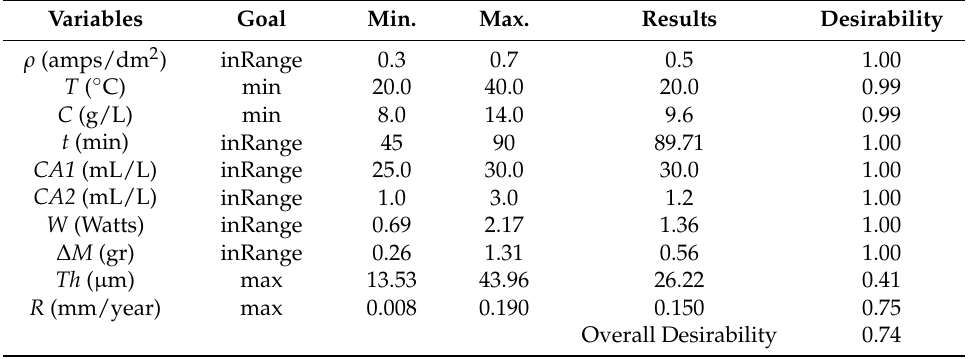
Table 16. The seventh criterion that was considered: maximizing the thickness ( Th ) and the resistance ( R ), while minimizing the temperature ( T ) and the concentration ( C